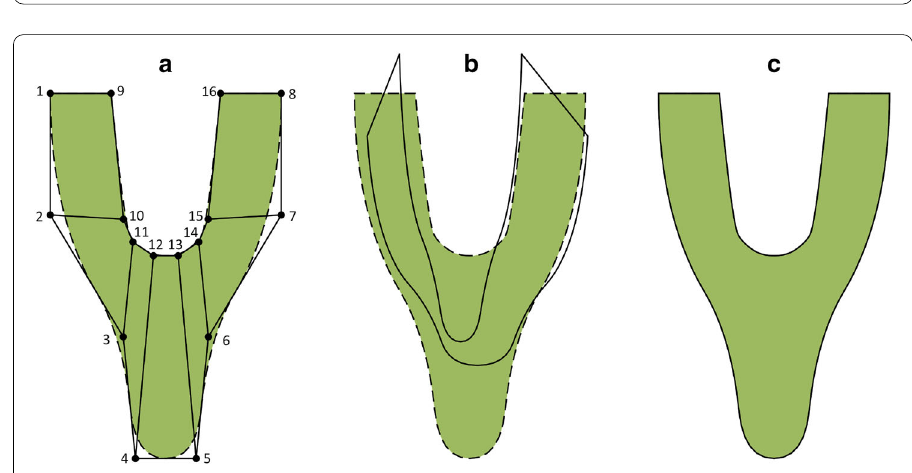
Fig. 5 Relative error norm versus the number of modes involved in the temperature separated representation for different meshes